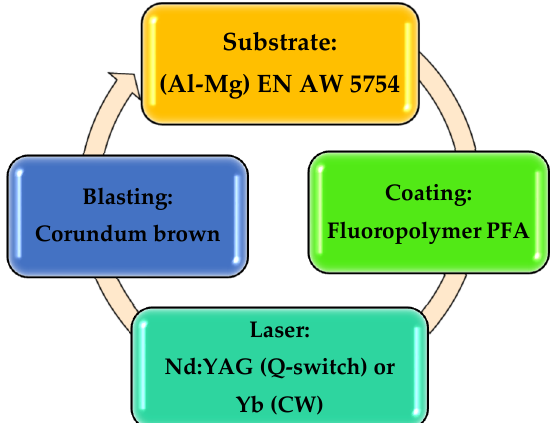
Figure 1. Schematic representation of the perfluoro alkoxy alkane (PFA) laser stripping process presented in this paper.